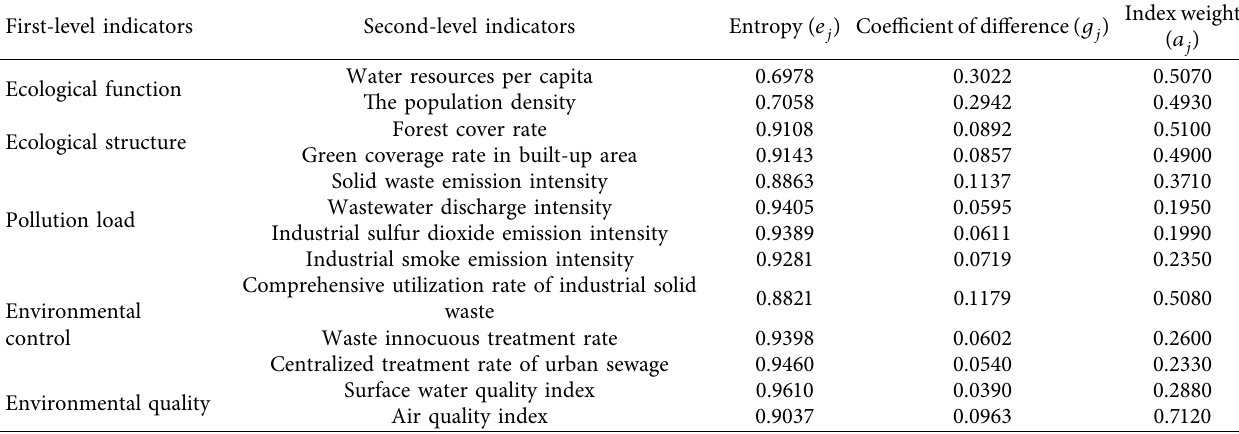
Table 2: The weights of the second-level indicators of the environmental quality assessment of the ecological reserve in Zhangjiakou city.